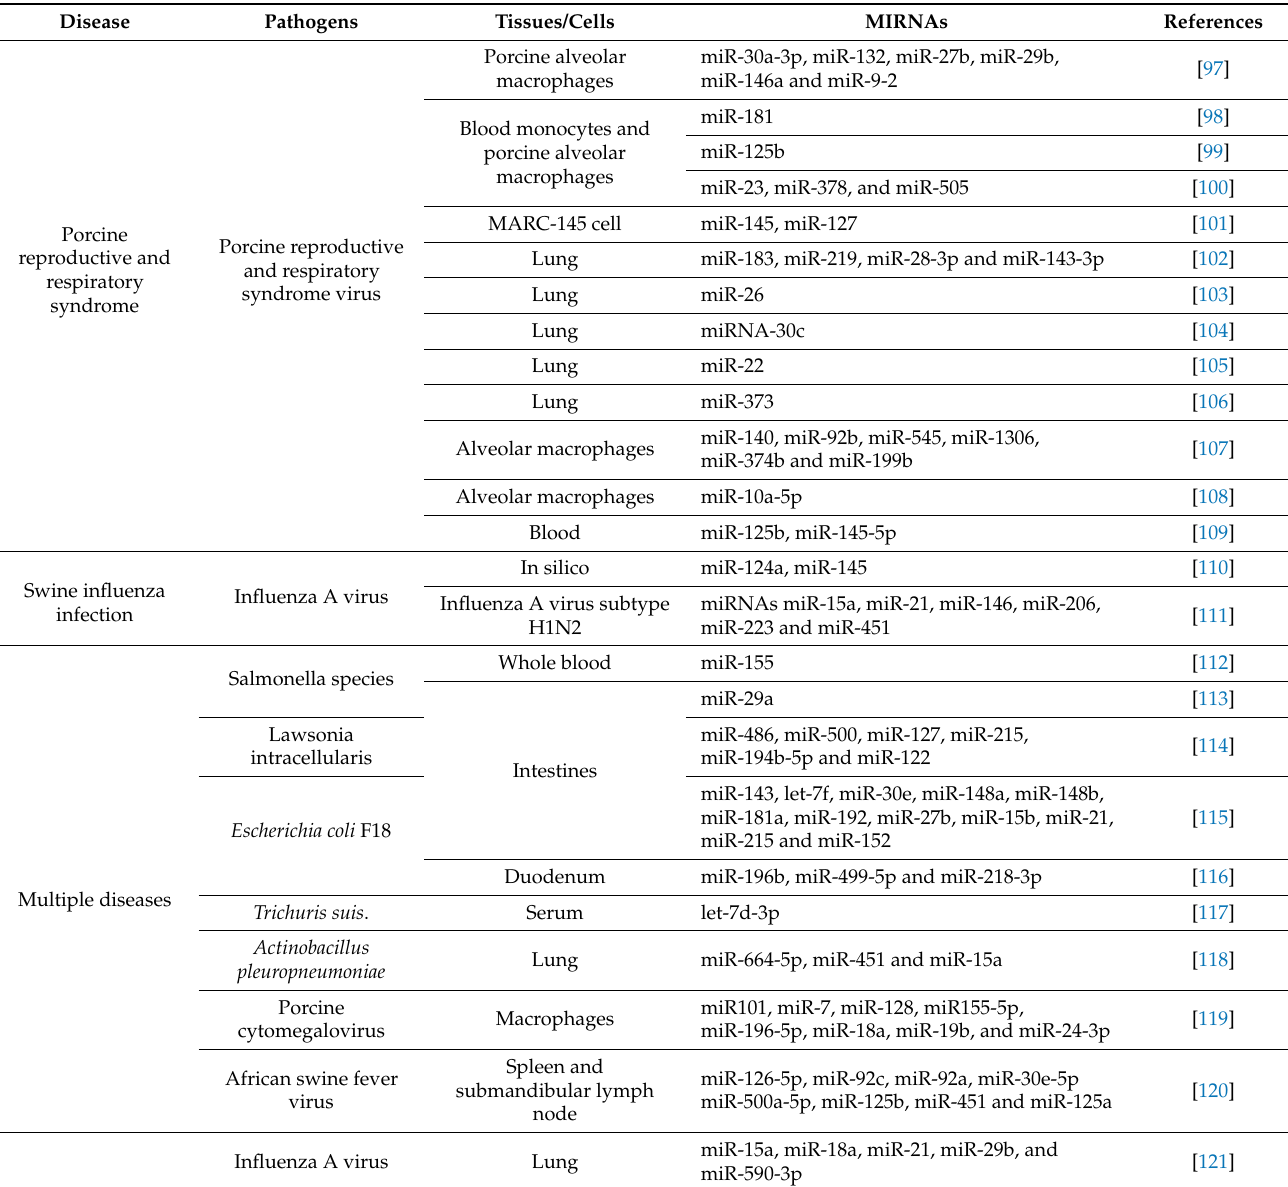
Table 3. Important miRNAs for pig